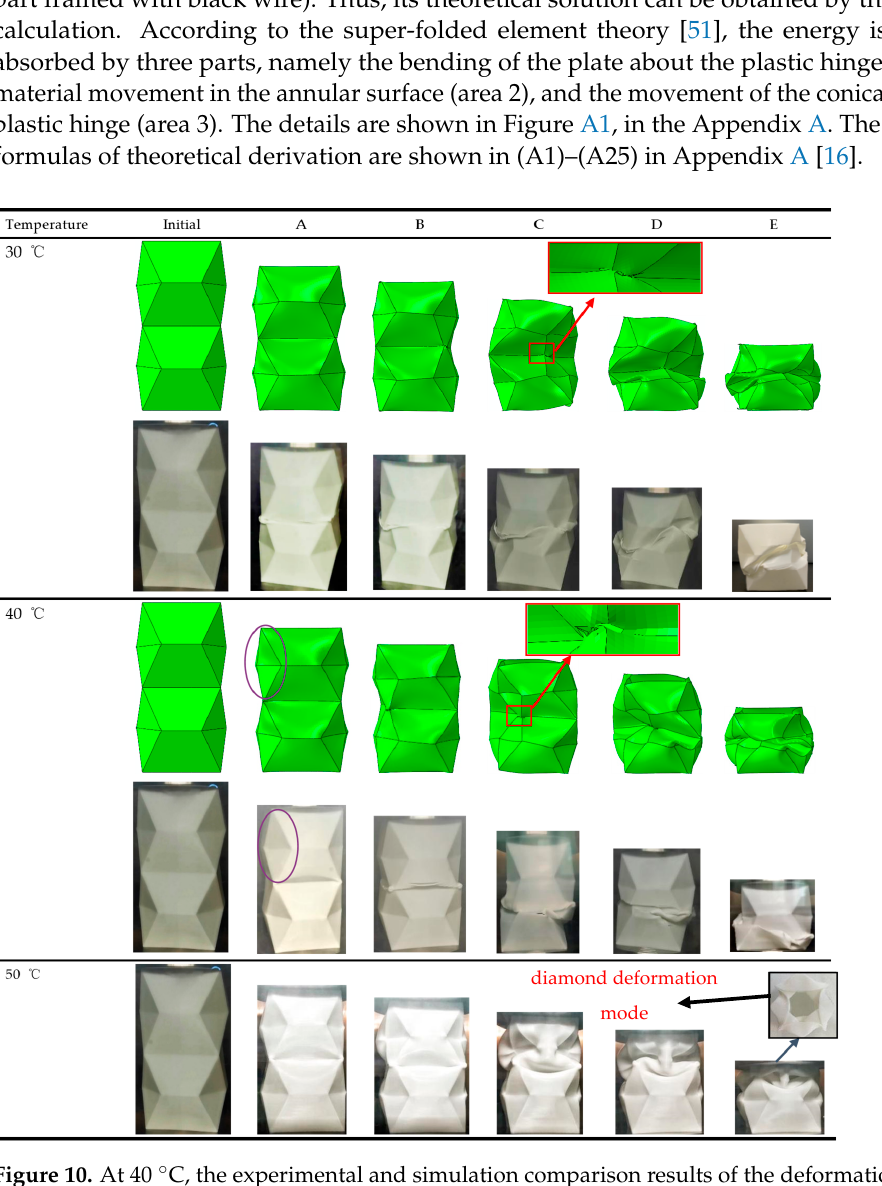
Figure 10. At 40 ◦ C, the experimental and simulation comparison results of the deformation modes of